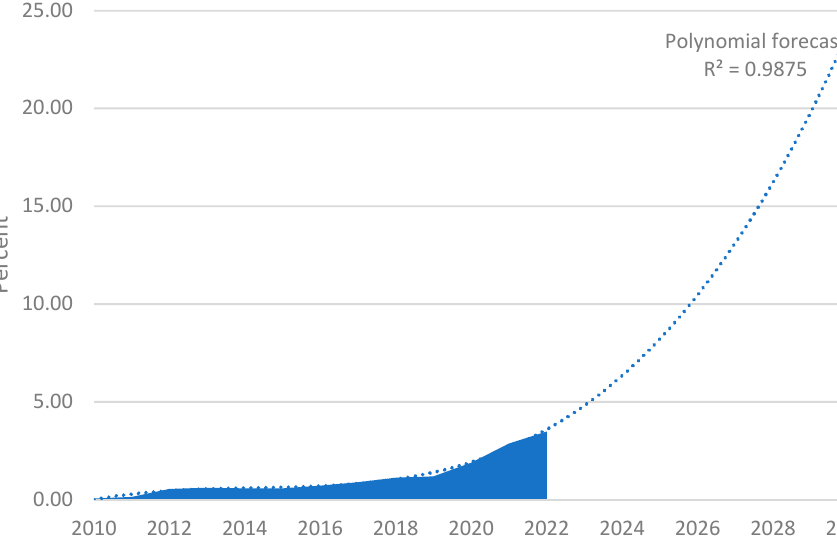
Figure 4. Newly registered LCVs—BEVs, PHEVs and alternative fuels . Source: EAFO [89].